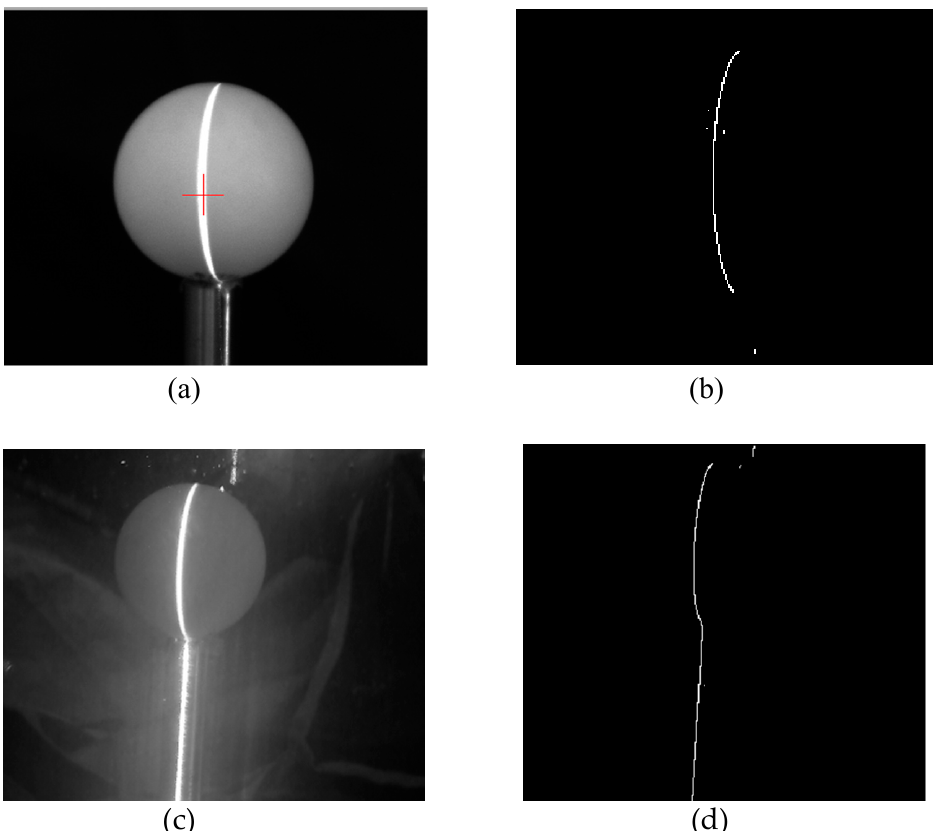
Figure 10. Measurement value and error of standard ball at different distances. ( a ) Reconstruction of standard sphere in air; ( b ) Extraction of laser stripe center in air; ( c ) Reconstruction of standard sphere in water; ( d ) Stripe center extraction of underwater standard sphere.